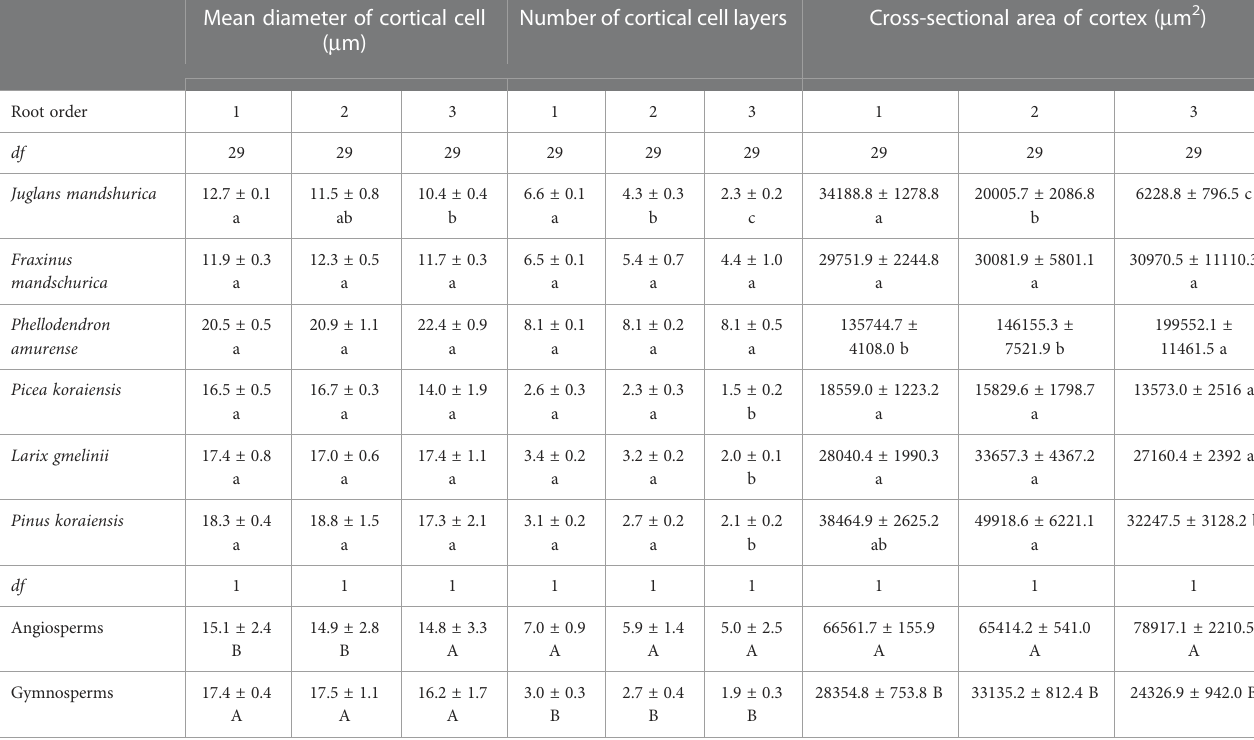
TABLE 2 The mean and standard error of cortical cell traits for the fi rst three absorptive root orders in three angiosperms and three gymnosperms tree species ( n =